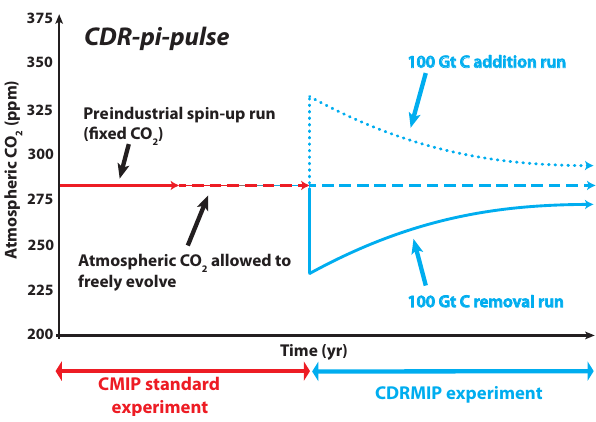
Figure 3. Schematic of the CDRMIP instantaneous CO 2 removal and addition from an unperturbed climate experimental protocol ( CDR-pi-pulse ). Models are spun up for as long as possible with a prescribed preindustrial atmospheric CO 2 concentration. Then at- mospheric CO 2 is allowed to freely evolve for at least 100 years as a control run. The negative–positive pulse experiments are conducted by instantly removing or adding 100GtC to the atmosphere of a simulation in which the atmosphere is at steady state and CO 2 can freely evolve. These runs continue for as long as computationally possible.